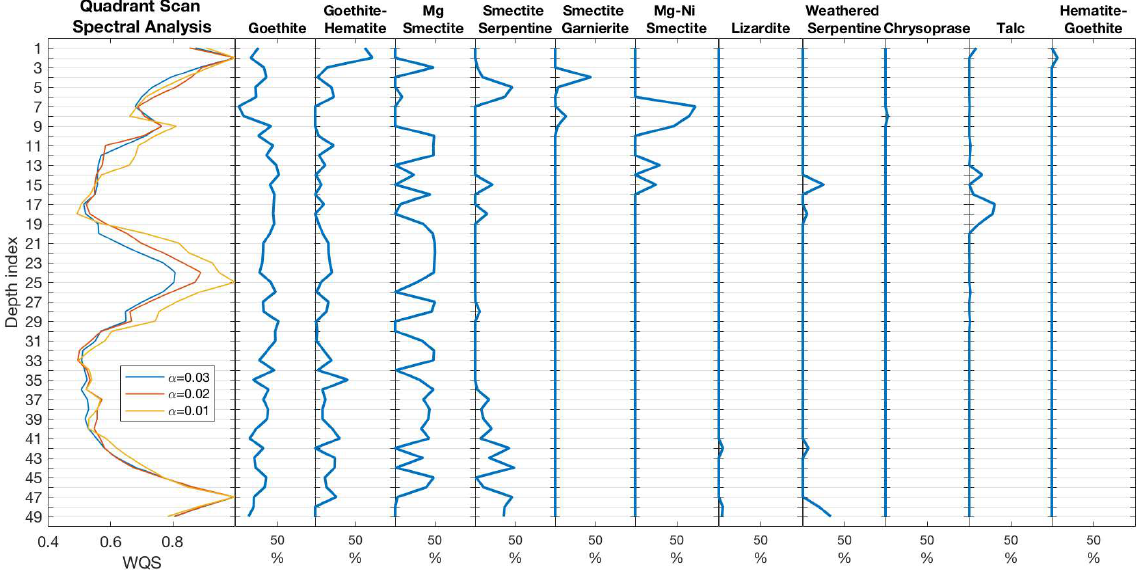
Figure 9. OUACO drill-hole: The WQS analysis in comparison with the abundance percentage of different minerals obtained with Corescan. The left panel is the WQS results from the spectral data using three different values of α , peaks indicate lithological, alteration and weathering boundaries. The rest of the panels show the abundance percentage of different minerals along the drill-hole.